Question: What visual encoding does this figure use to show its data?
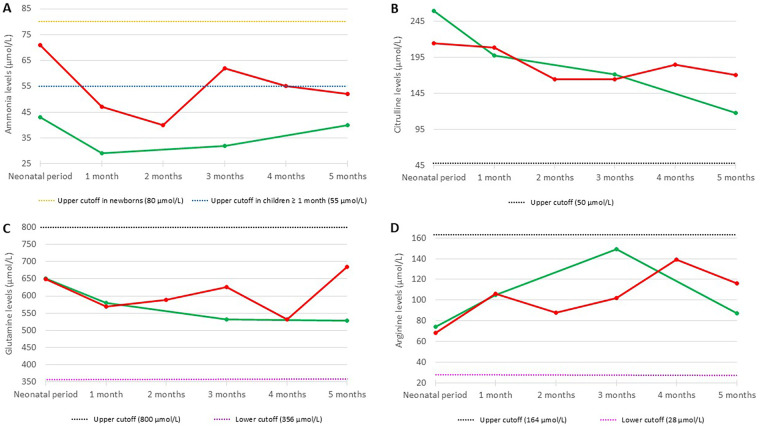
Answer: line